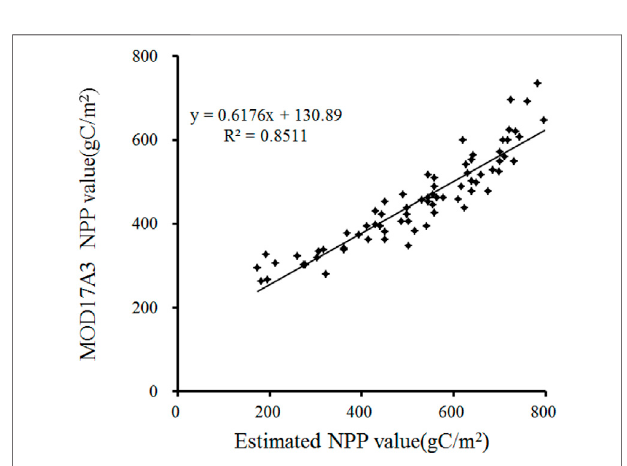
FIGURE 3 | Correlation between the estimated NPP values and MOD17A3 NPP values.